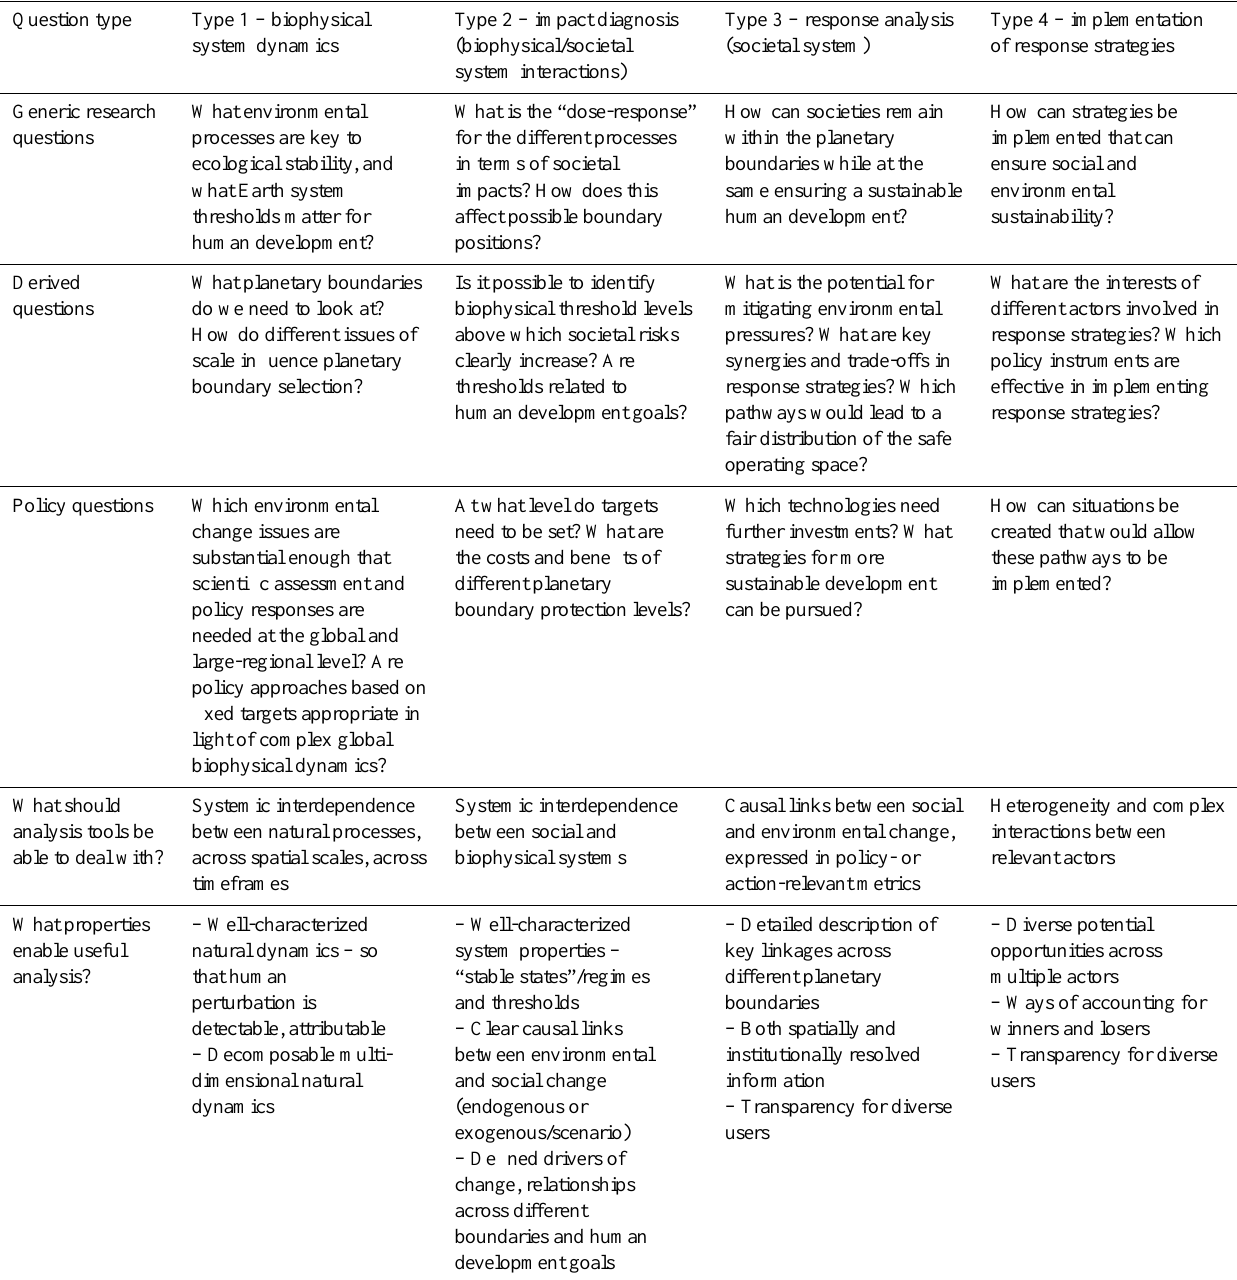
Table 1. Typology of key questions for research related to planetary